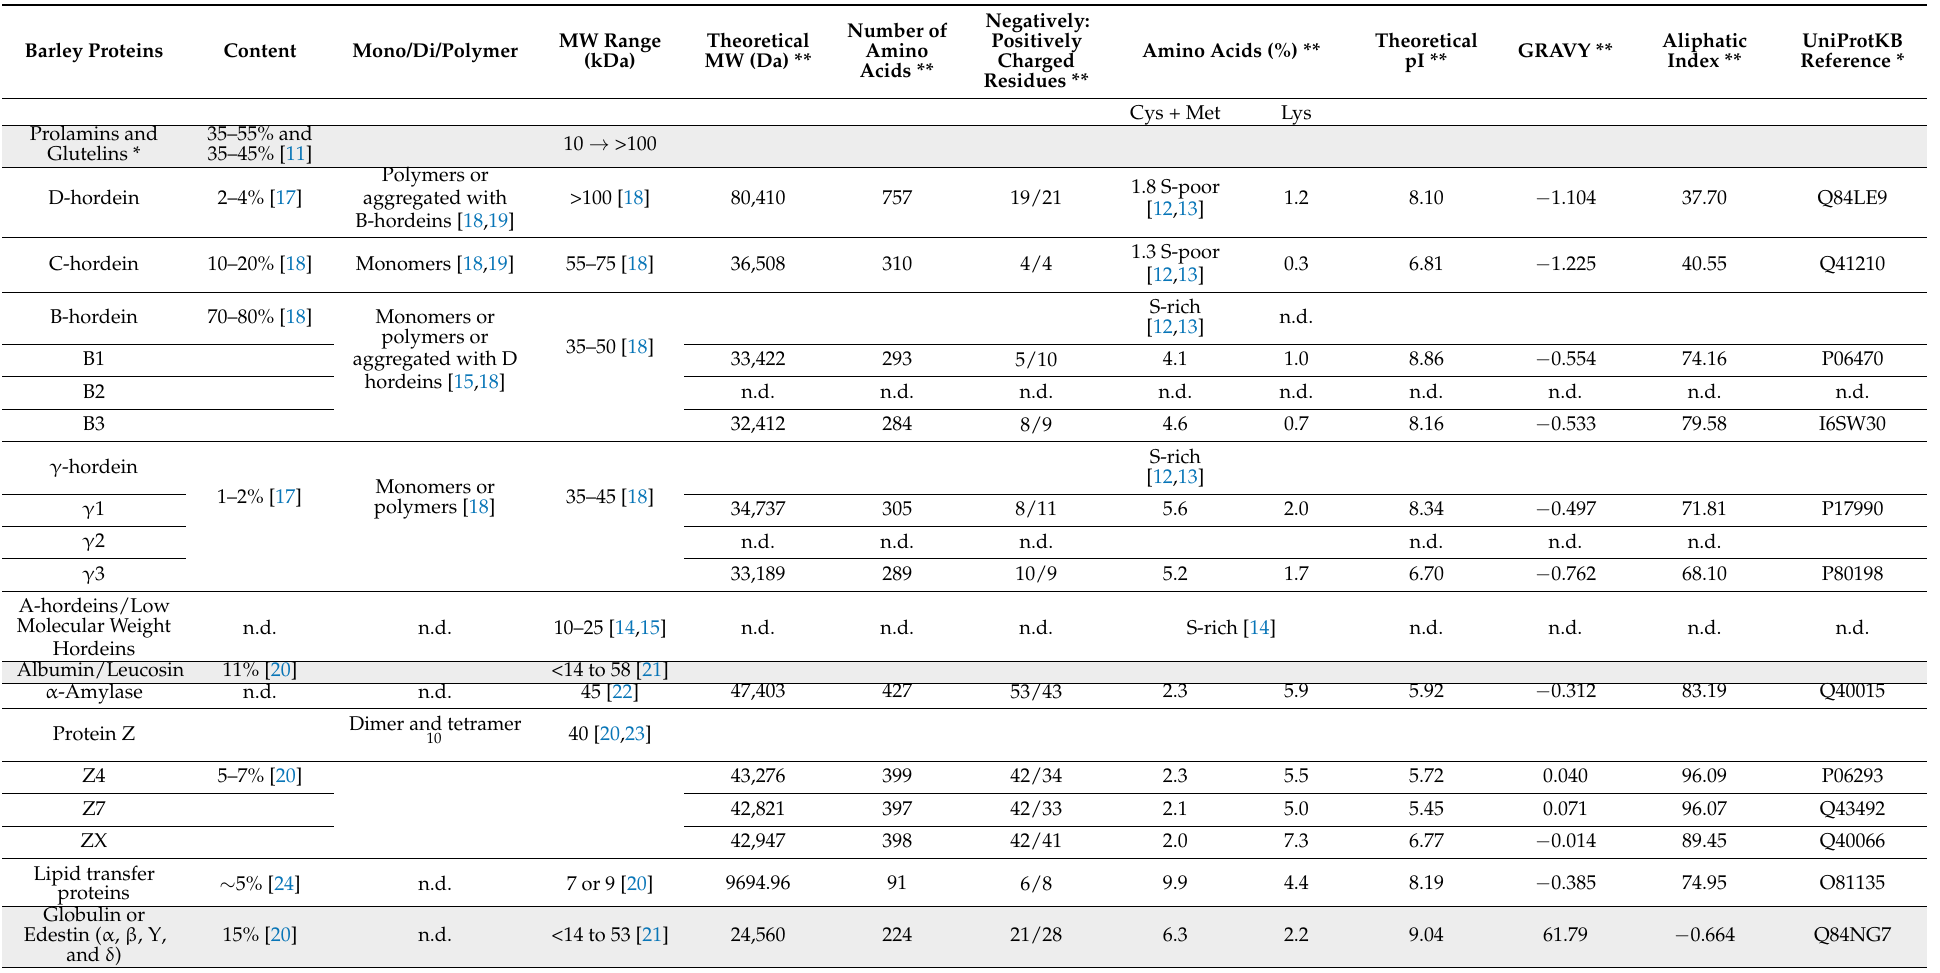
Table 2. Composition and structure of barley